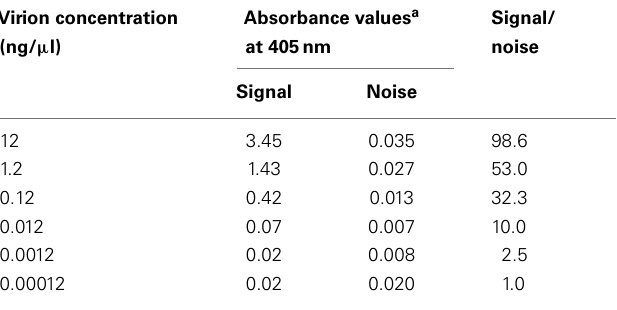
Table 1 |Virion recognition specificity of biotinylated-anti-LIYV IgG in